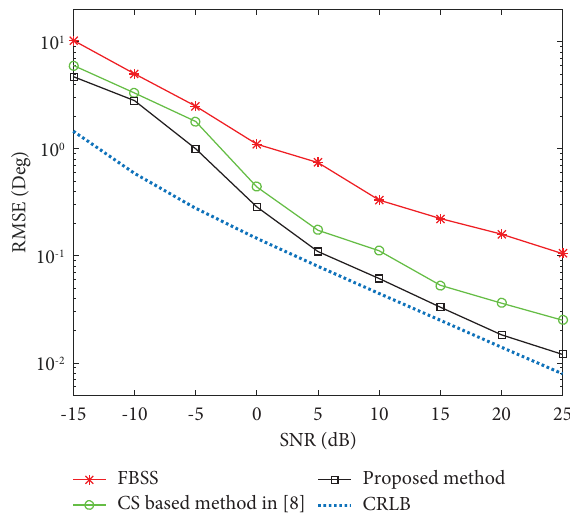
Figure 1: Beam patterns indiferent conditions.